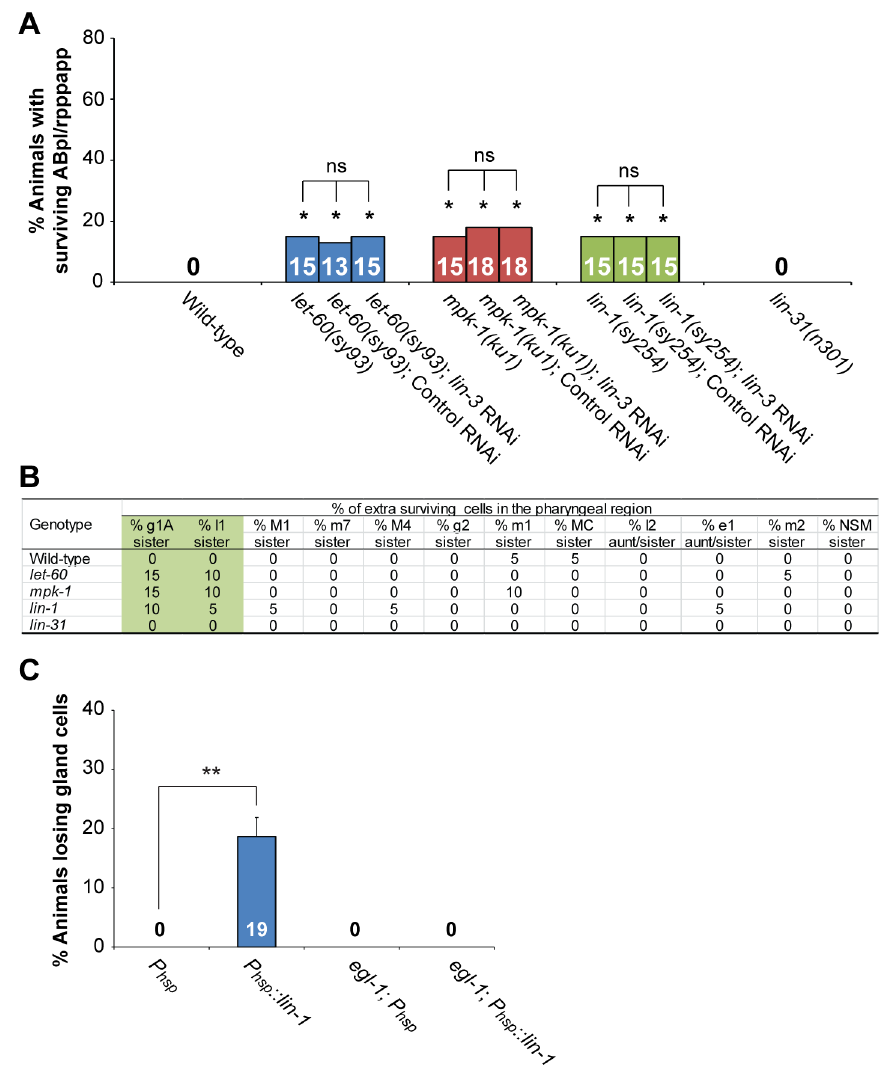
Figure 5. lin-3 , lin-1 and the LET-60-MPK-1 pathway act in the same pathway to promote PCD. (A) The percentage of worms with surviving ABpl/rpppapp of the indicated genotypes was shown. *indicates P , 0.05 when compared to the wild-type (Fisher’s exact test). ns indicates no statistical difference (p . 0.05). More than thirty worms were scored for each genotype. (B) Analysis of extra surviving cells in the pharyngeal region (n=20). Alleles used here are let-60(sy93), mpk-1(ku1), lin-1(sy254), and lin-31(n301) . (C) The percentage of wild-type or egl-1(n1084n3082) worms carrying the indicated transgene that lost gland cell(s) in the pharynx was shown. ** P , 0.001 (Fisher’s exact test). The gland cells were scored using the tpIs8 transgene, and the worms were treated with heat shock as described in Materials and Methods. P hsp ::lin-1 or P hsp indicate the transgenes, in which lin-1 or no cDNA was expressed under the control of the heat-shock promoter, respectively. More than forty worms were scored for each